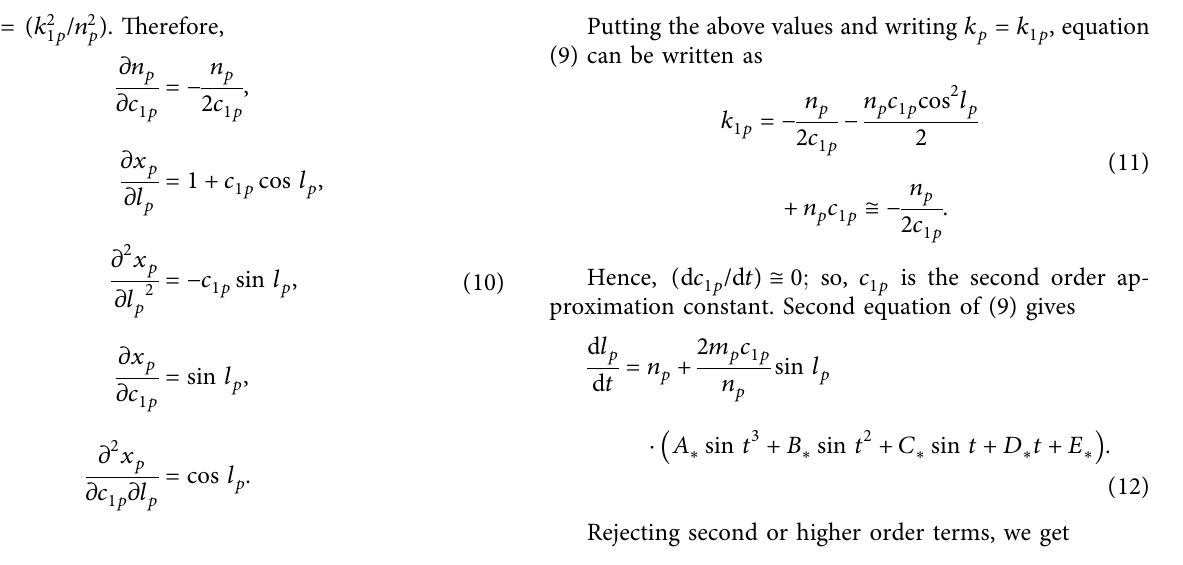
3: For n � 0 . 0001 , ε � 0 . 00000000000001 ,A and e � 0 . 001. (a) Poincare map, (b) Poincare surface of section, (c) Lyapunov exponent, and (d) time